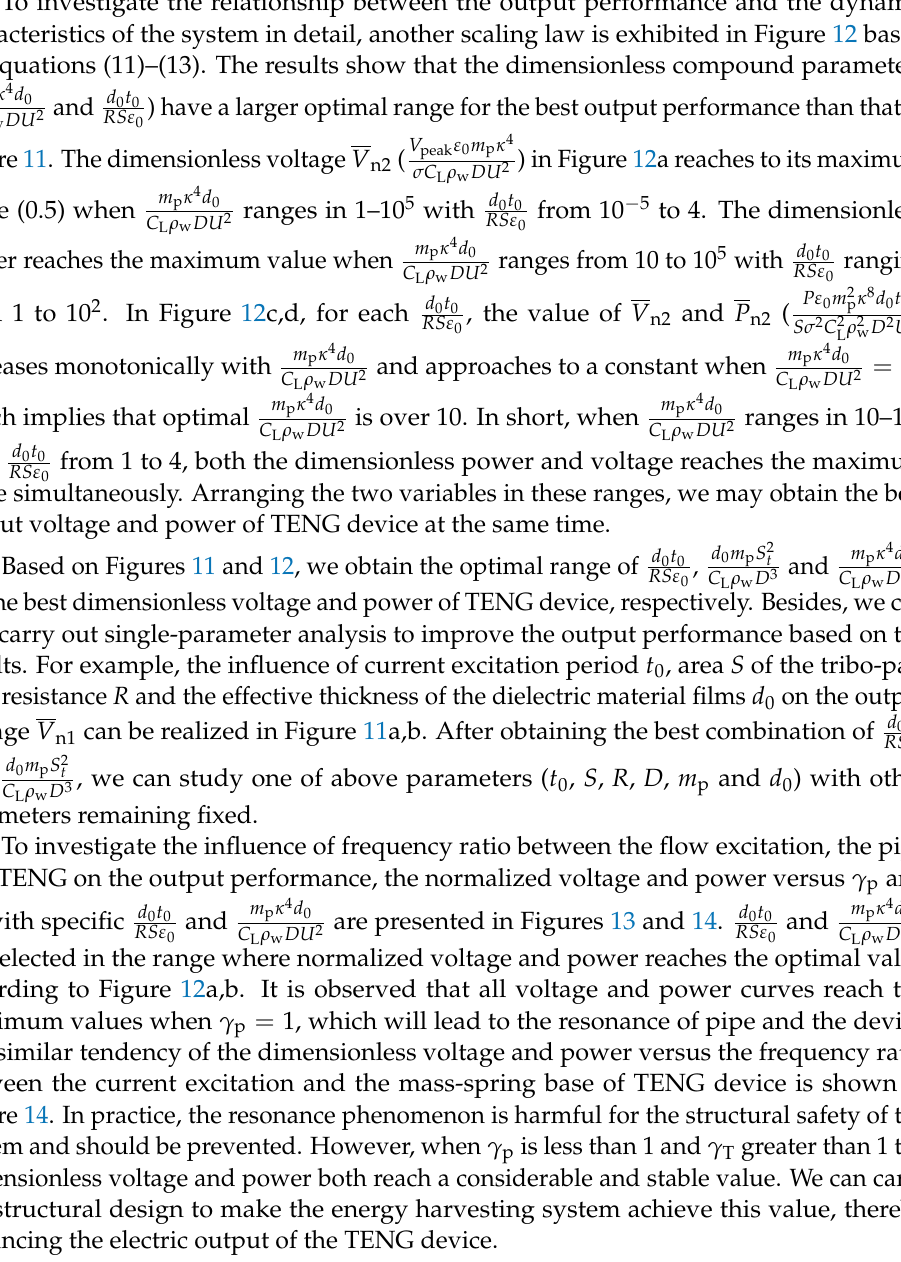
V peak ε 0 m p κ 4 Figure 11. The dimensionless voltage V n2 ( ) in Figure 12a reaches to its maximum σ C L ρ w DU 2 m p κ 4 d 0 value (0.5) when ranges in 1–10 5 with d 0 t 0 from 10 − 5 to 4. The RS ε 0 C L ρ w DU 2